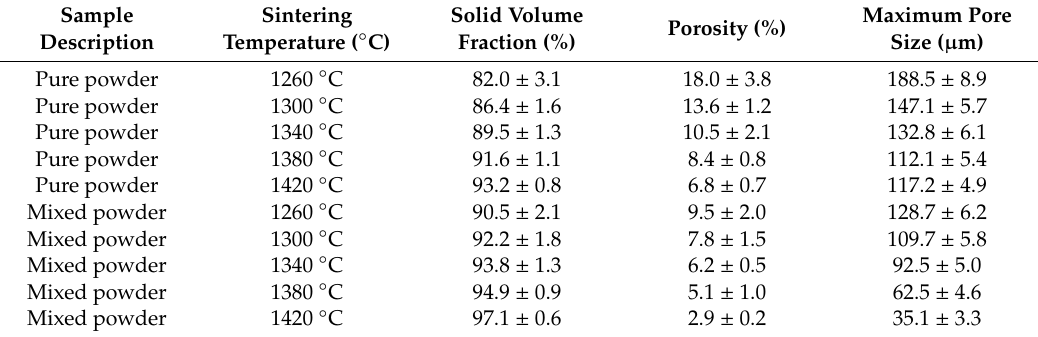
Figure8. Opticalmicrographsofpolishedsinteredsamplesatdi ff erenttemperatures: ( a – e )purepowder; ( f – j ) mixed powder. Scale bar = 200 µ m. Table 2. Image analysis results on micrographs (shown in Figure 8) obtained from the sintered samples at di ff erent sintering